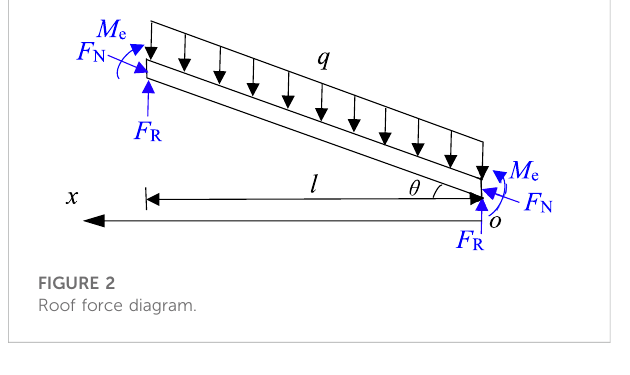
FIGURE 4 Variation characteristics of the difference of the maximum roof de fl ection.